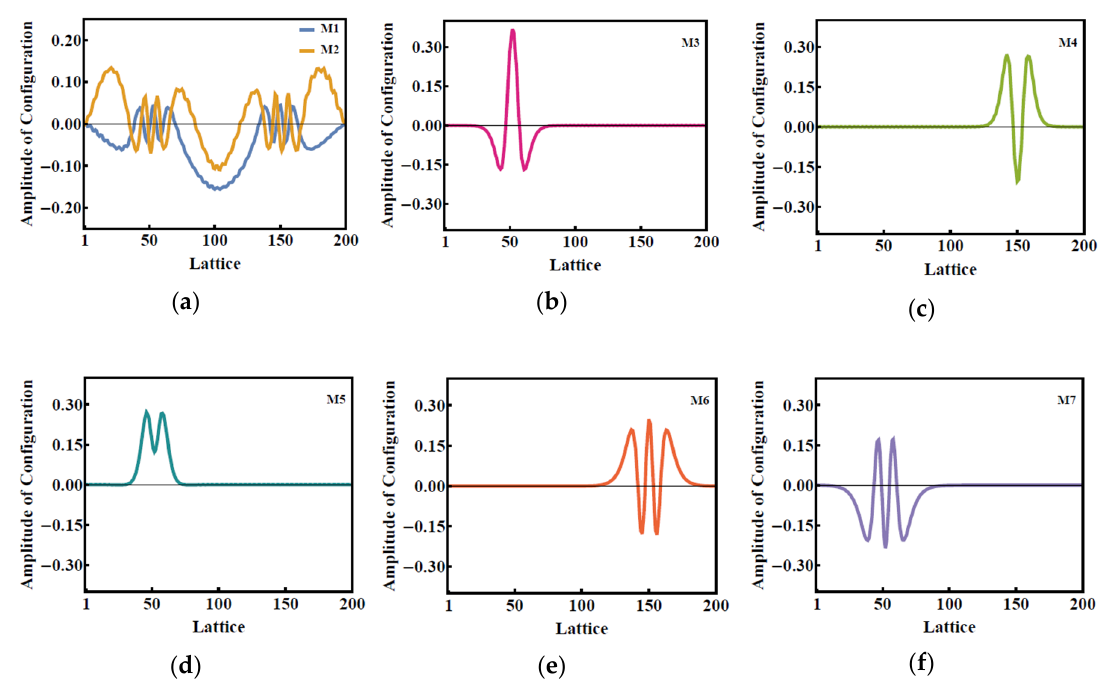
Figure 4. ( a ) Extensive lattice vibrational modes and ( b – f ) local lattice vibrational modes under pumping by an external laser of 70 µ J / cm 2